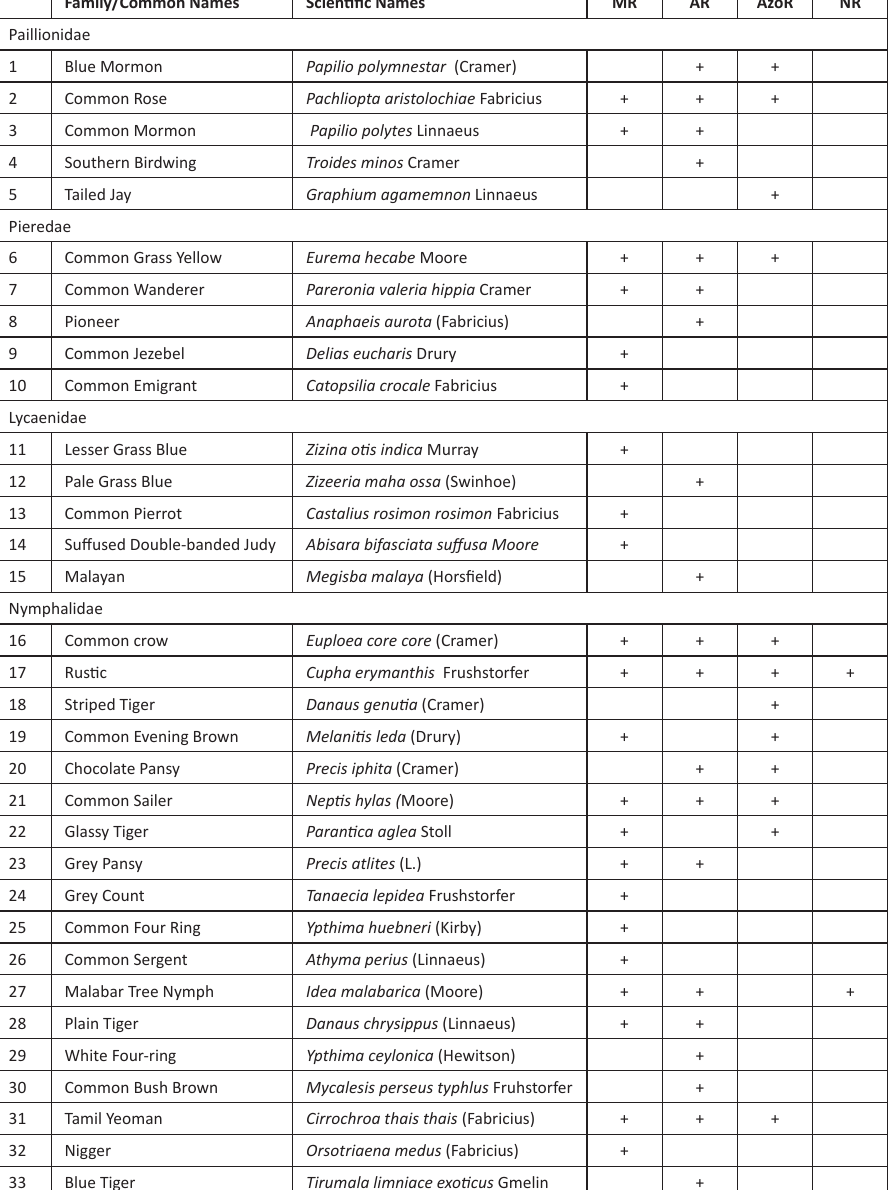
Table 1. Checklist of butterflies with their scientific names and their occurrence in different